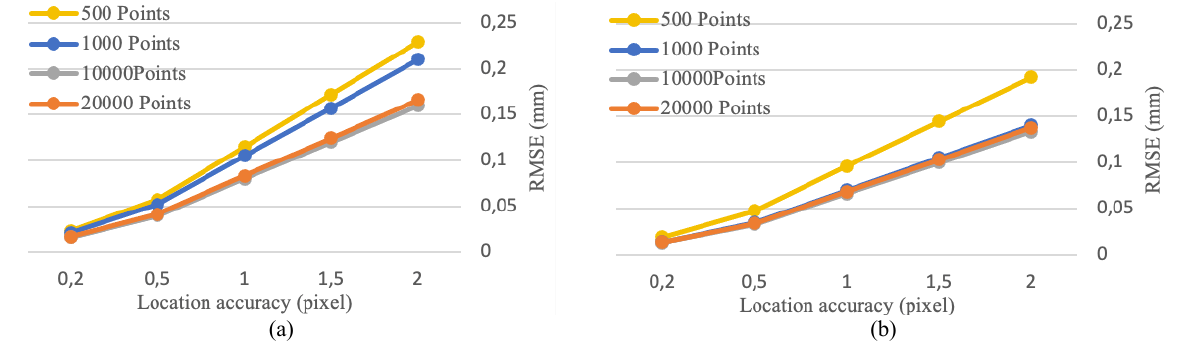
Figure 6 . Achieved RMSE of 3D points when location uncertainty is changing. UAV straight block with 24 images (large baselines - a) and 48 images (short baselines - b).